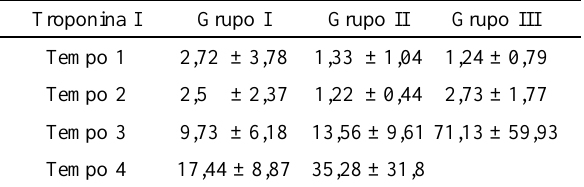
2. Valores médios com seus respectivos desvios-padrão, da troponina I, expressos em ng/ml, nos animais dos grupos I, II e III, submetidos em CEC, a duas horas de isquemia e três horas de reperfusão.